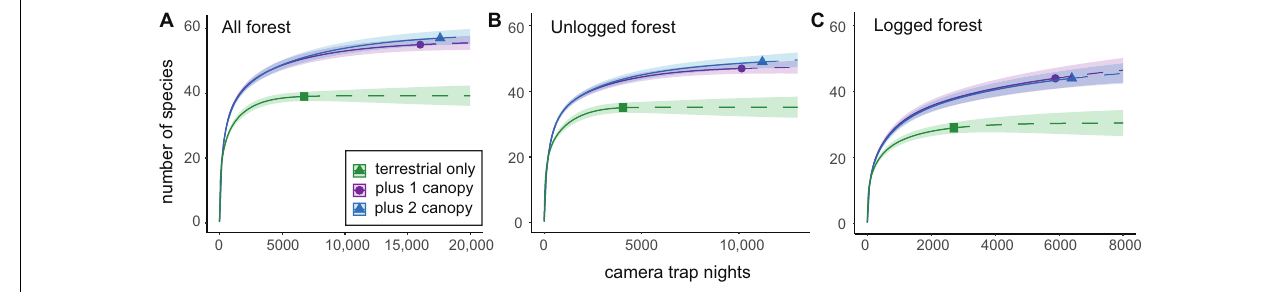
FIGURE 4 | Species accumulation curves comparing species numbers obtained from 19 camera-traps set solely at terrestrial-level, with those obtained by pooling data from terrestrial- plus one canopy camera-trap, and terrestrial- plus two canopy camera-traps. Inventories are shown for panel (A) both forest types combined, (B) unlogged forest, and (C) logged forest. Confidence intervals were set at 84% in line with Figure 2 (MacGregor-Fors and Payton, 2013) and are represented by shaded areas under the curves. Analyses here represent data from the entire sampling period, totaling 6,661 CTN for terrestrial camera-traps, 9,156 CTN for single canopy camera-traps, and 1,409 CTN for experimental second canopy camera-traps. Analyses were repeated using a standardised subset of 1,409 CTN (the minimum trapping effort arising from the second canopy camera-traps), and these are presented in Supplementary Figure 3 for